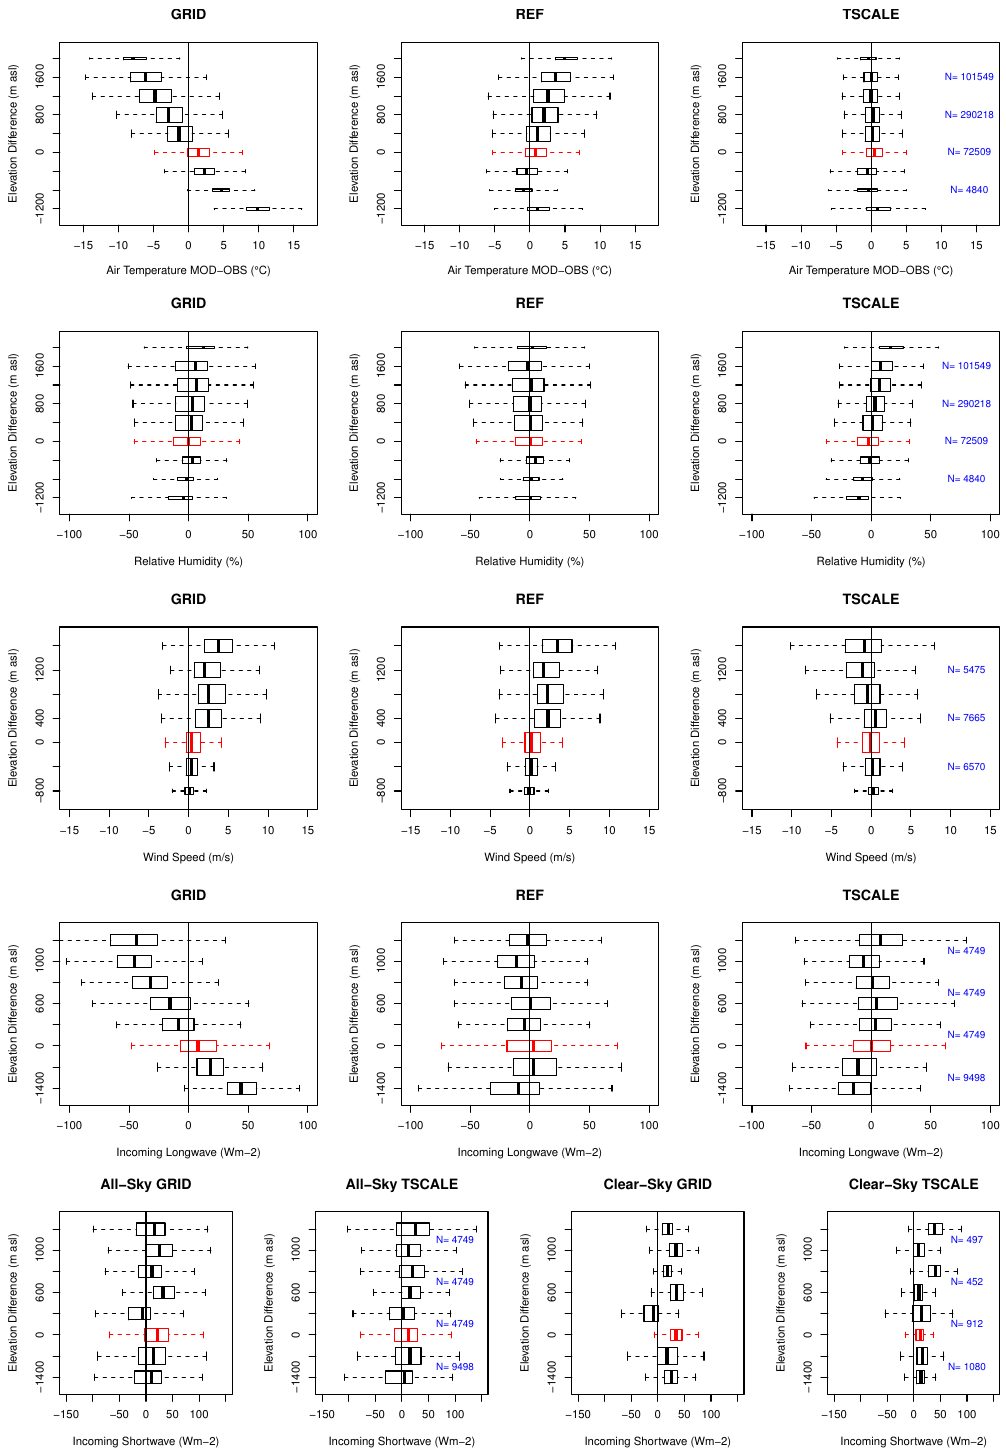
Fig. 12. Daily mean error of modelled variables with respect to observations (OBS-MOD) of GRID, REF and TopoSCALE as a function of elevation of station with respect to ERA-I grid elevation (of that station). The plot is binned into 400m intervals. The red box represents surface data (grid-level ± 200m). Number of data points in each box are given in blue (IMIS-Data© 2013,